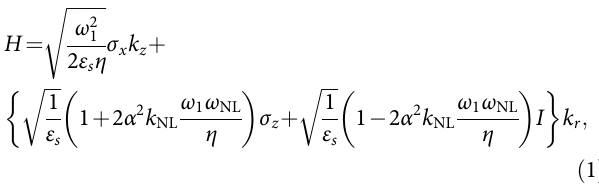
where σ x,z are Pauli matrices, ω 0 is the cut wires ’ resonance frequency, ω 1 ¼ 1 (cid:2) α 2 k 2 angular frequency, k NL is the NL ’ s radial direction ’ s momentum,